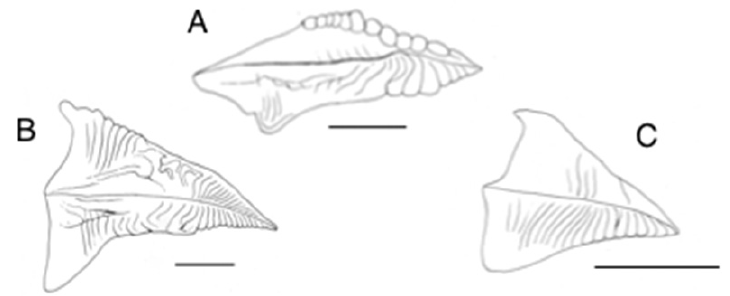
Figure 5. Right hemipalps with outer one reflected: A Pharaonella amanyu B Tonganaella tongana C P. sieboldii . Scale bar 5